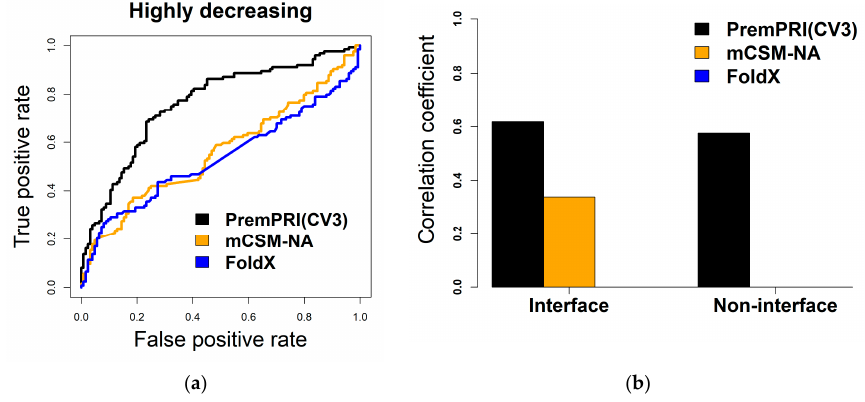
Figure 2. Performance of three methods of PremPRI, mCSM-NA, and FoldX applied to the S248